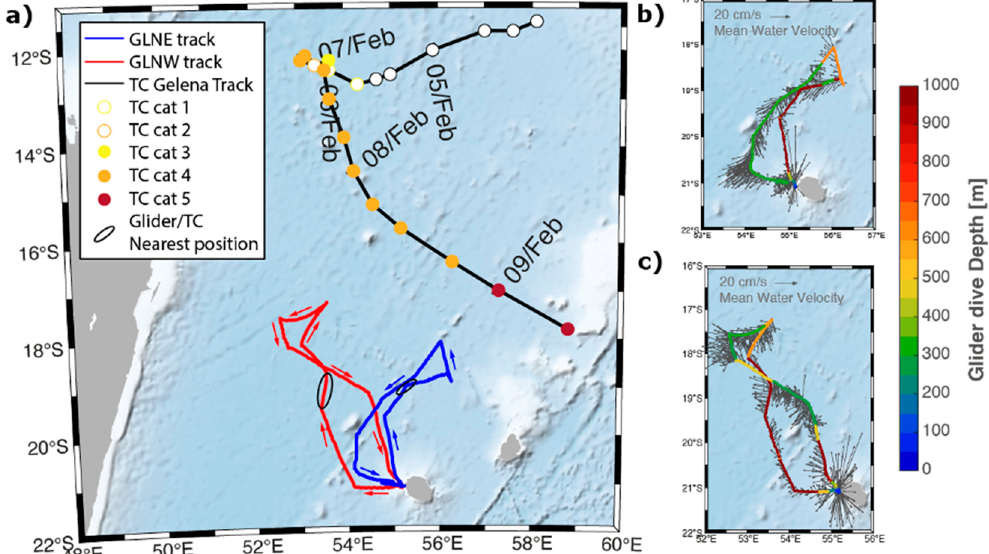
Figure 12. Trajectories of the two gliders deployed from Réunion Island between 22 January 2019 and 22 March 2019. ( a ) Trajectories of glider GLNE (blue) and GLNW (red), together with the trajectory and intensity (colored dots) of TC GELENA between 5 and 9 February. The positions of the gliders during the TC period are indicated by black ellipses. Right panels show cast depth range and mean current velocities along the glider tracks estimated from glider drift for ( b ) GLNE and ( c ) GLNW. Table 1: Glider instrumentation, sampling rate (Hz), vertical resolution (m) and depth range (m) of collected data.